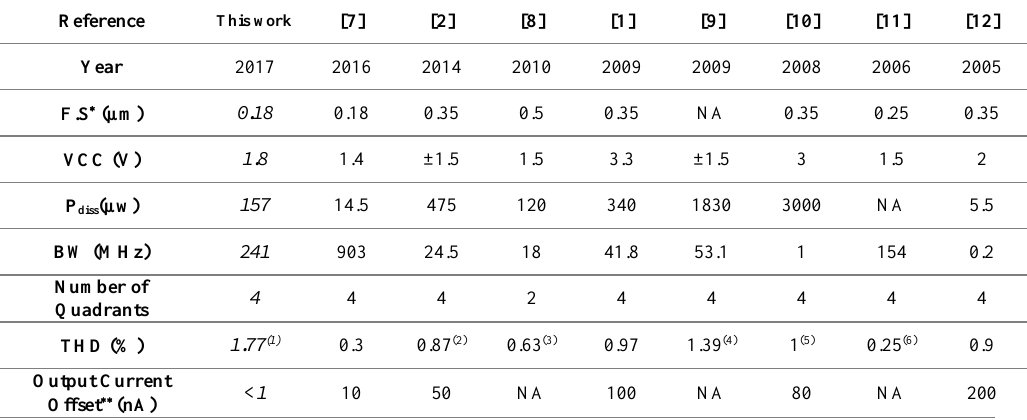
Table 3. Comparison between this work and other reported